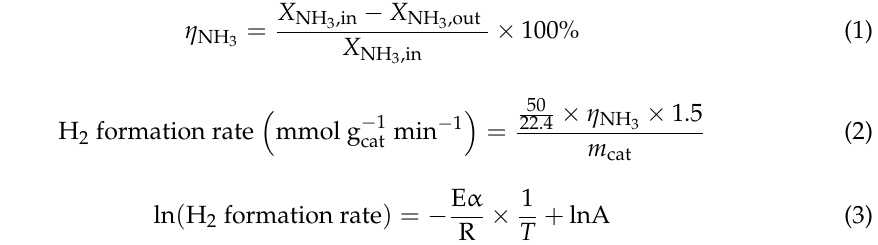
Figure 1. The related Brunauer–Emmett–Teller (BET) surface areas are summarized in Table 1. The specific surface areas of the fresh Fe, Fe 0.75 Cr 0.25, Fe 0.5 Cr 0.5, Fe 0.25 Cr 0.75 , and Cr were 13 m 2 /g, 62 m 2 /g, 84 m 2 /g, 51 m 2 /g, and 39 m 2 /g, respectively. The